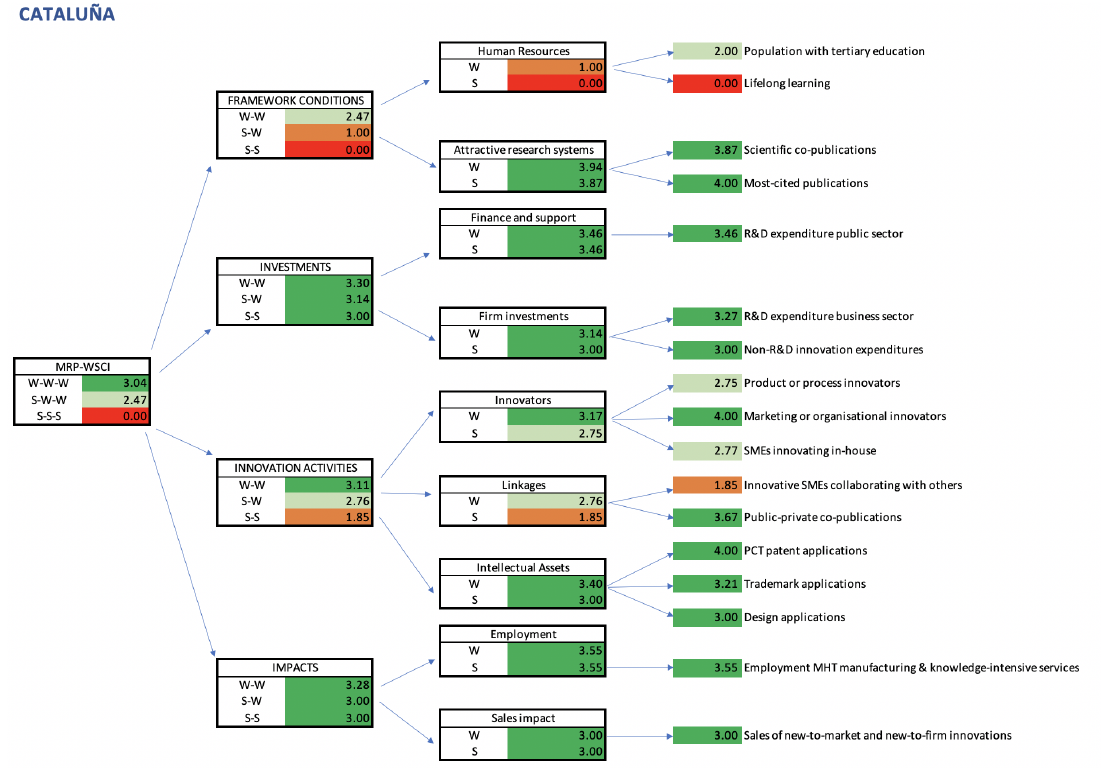
Figure 10. Light-Diagram for (ES51) Cataluña in 2019: Spanish reference levels.